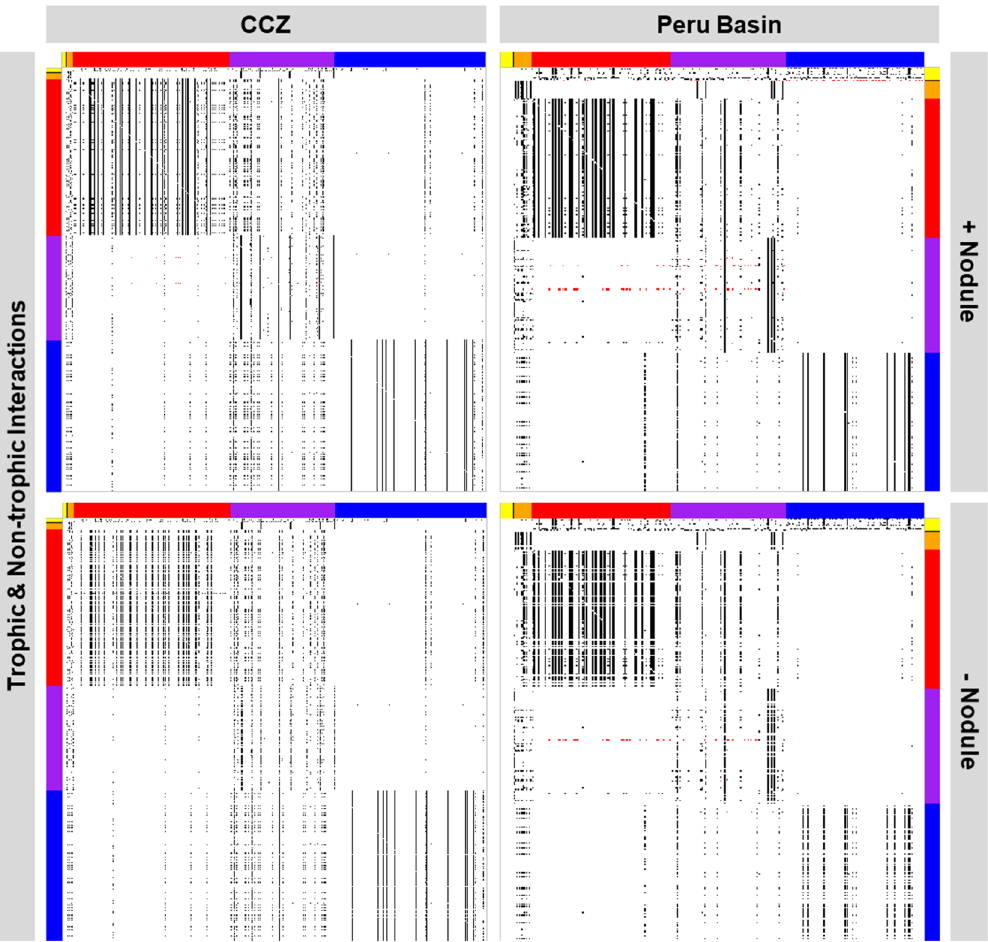
Figure 2. Network links between food-web compartments. Each individual dot represents an interaction between polymetallic nodules (black section) and faunal food-web compartments (orange, red, purple, and blue sections), two faunal food-web compartments, or a faunal food-web compartment and the food-source compartment (yellow section). (Top left) Trophic (black) and non-trophic (red) interactions or links in the Clarion-Clipperton Fracture Zone (CCZ) when polymetallic nodules are present. (Bottom left) All trophic (black) and non-trophic (red) interactions or links that remain in the Clarion-Clipperton Fracture Zone interaction webs after polymetallic nodule removal. (Top right) All trophic (black) and non-trophic (red) interactions or links that exist in the Peru Basin when polymetallic nodules are present. (Bottom right) All trophic (black) and non-trophic (red) interactions or links that remain after polymetallic nodule removals in the Peru Basin interaction webs. Color code of axes: yellow food sources, black polymetallic nodules, orange fish, red macrobenthos, purple megabenthos, blue